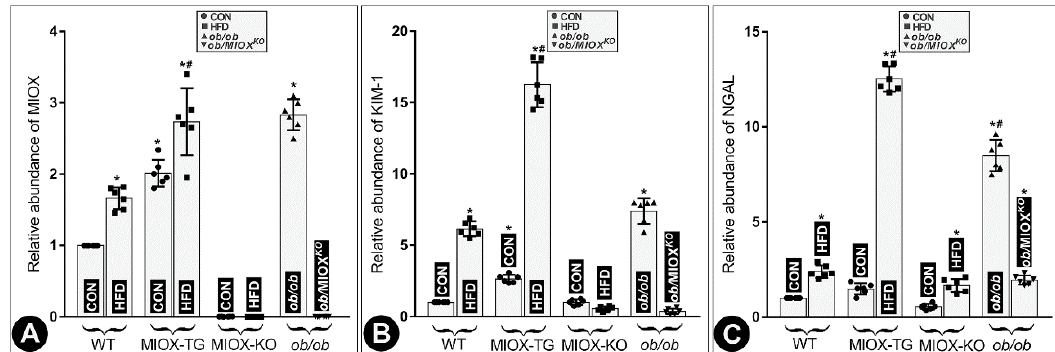
Figure 1. High fat diet (HFD) administration leads to increased expression of Myo-inositol oxygenase (MIOX) and perturbations in the biomarkers of renal injury in different strains of mice. Panel ( A ): following HFD administration, an increase in the MIOX expression was observed in wild type (WT) mice and a much higher increase was seen in MIOX transgenic (MIOX-TG) mice. No increase in MIOX expression was observed in MIOX KO mice fed with HFD. The ob/ob mice had very high MIOX expression and it was reduced to undetectable levels in ob /MIOX KO mutant mice. Panel ( B & C ): a parallel increase in the levels of both the renal injury markers, i.e., Kidney Injury Molecule-1 (KIM-1) and neutrophil gelatinase-associated lipocalin (NGAL) RNA, was observed in various strains of mice following HFD administration, and the most notable increase was observed in MIOX-TG mice. No increase in their expression was observed in MIOX KO mice. The ob/ob mice had a very high expression of KIM-1 and NGAL and it was remarkably reduced in ob /MIOX KO mice. ( n = 6; * P < 0.05 compared with the control group, # P < 0.05 compared with the HFD group, one-way ANOVA with Dunn’s multiple comparisons).